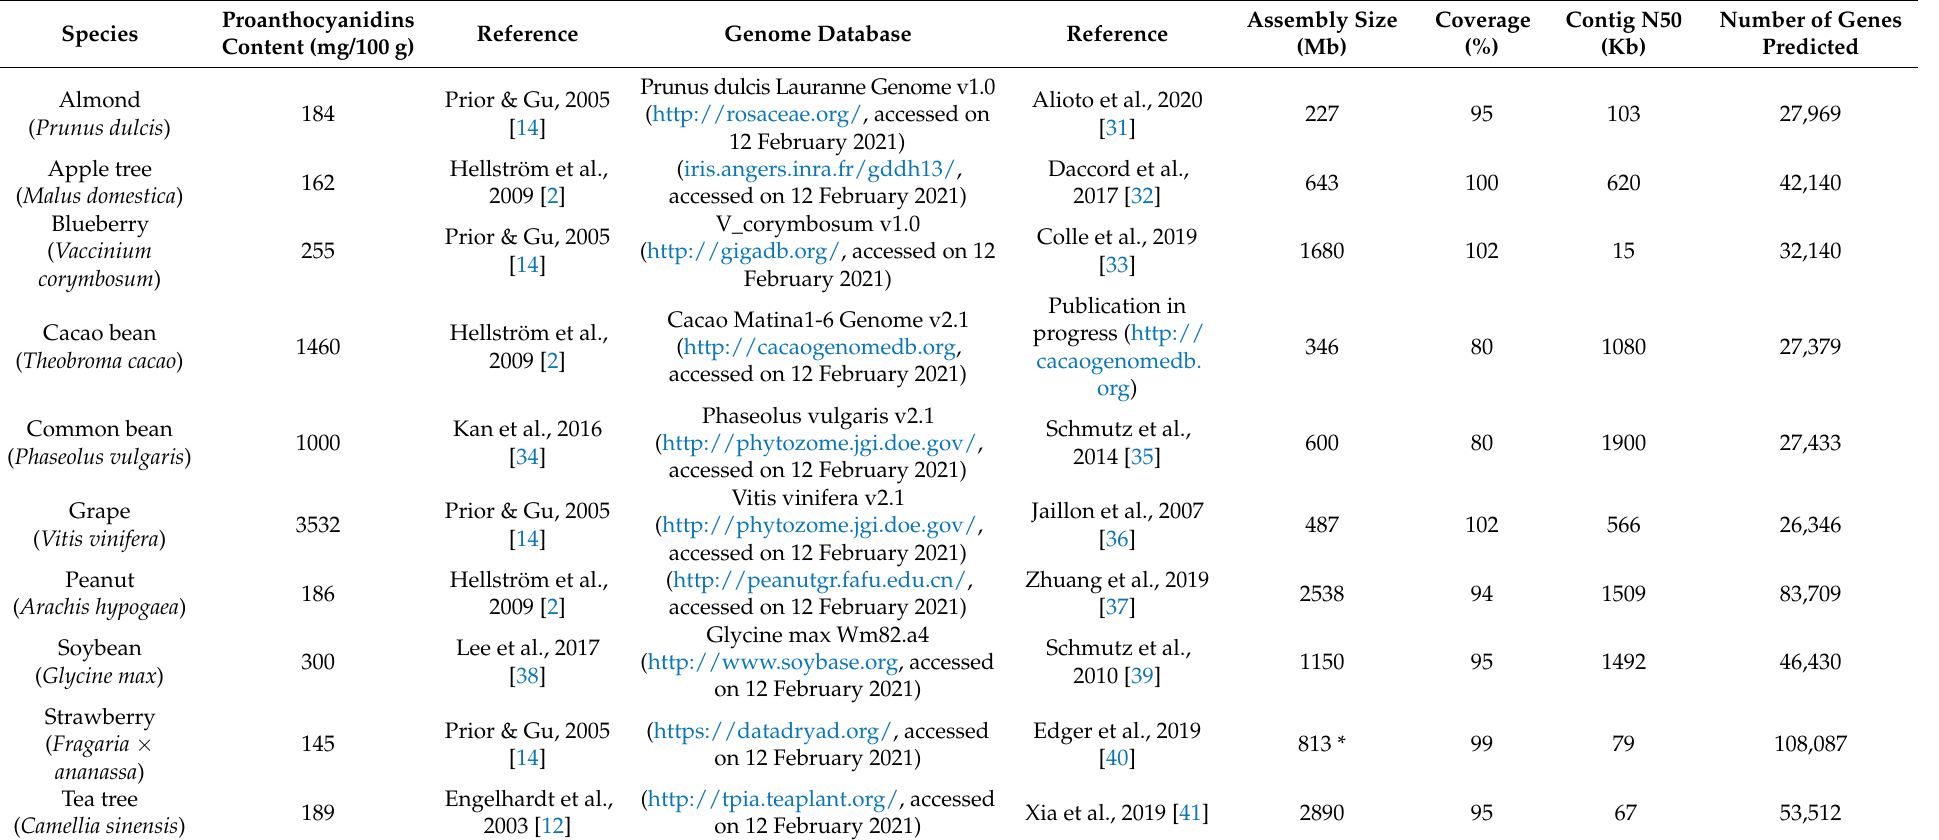
Table 1. List of 10 major crops containing high levels of proanthocyanidins and their reference genomic information. Among major crops with high contents of PAs, the species with currently available genomic databases were selected for this